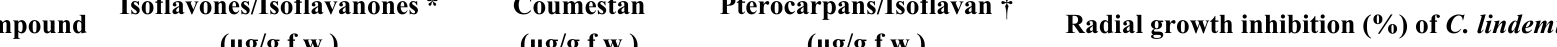
Table 1. Elicitor effect of some dihydro-quinazolinones and imines related structurally to SA (at 1.45 mM and after 96 h post-induction) in cotyledons of common bean cv. Cargamanto Mocho, and antifungal activity of the extracts from induced cotyledons.